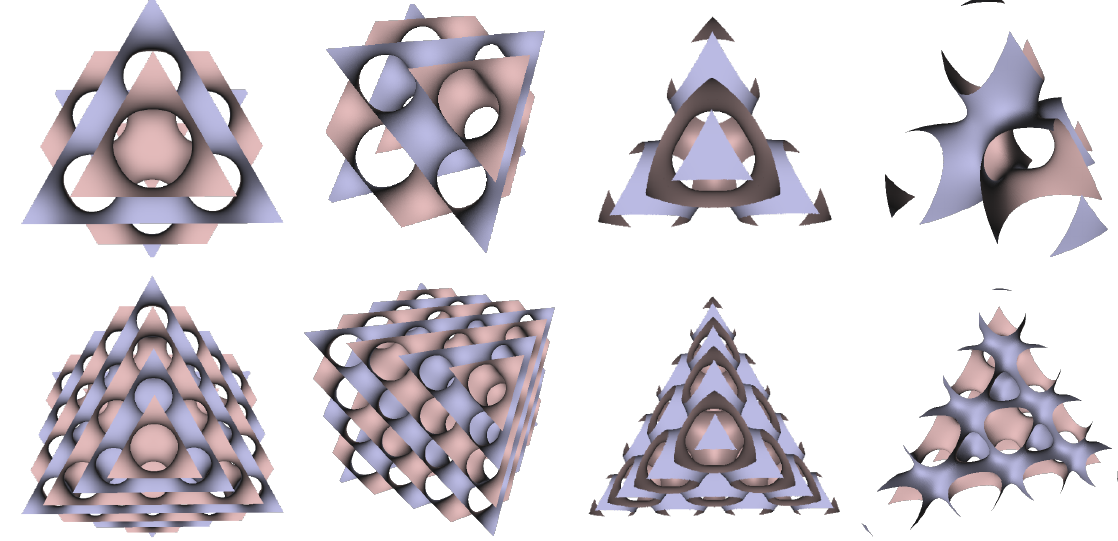
Figure 6. TPMS Schwarz D Surface (left two columns) vs. TIS D Surface (right two